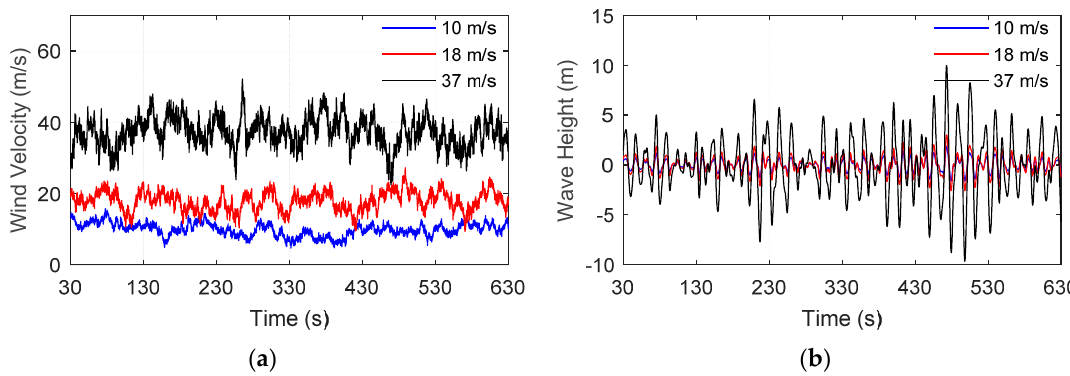
Figure 7. Time-history samples of environmental load conditions: ( a ) wind velocity; and ( b ) wave height.